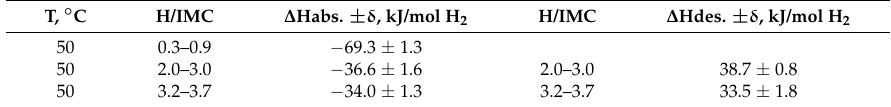
Table 3. The values of hydrogen absorption and desorption enthalpy in the Nd 2 Fe 14 B-H 2